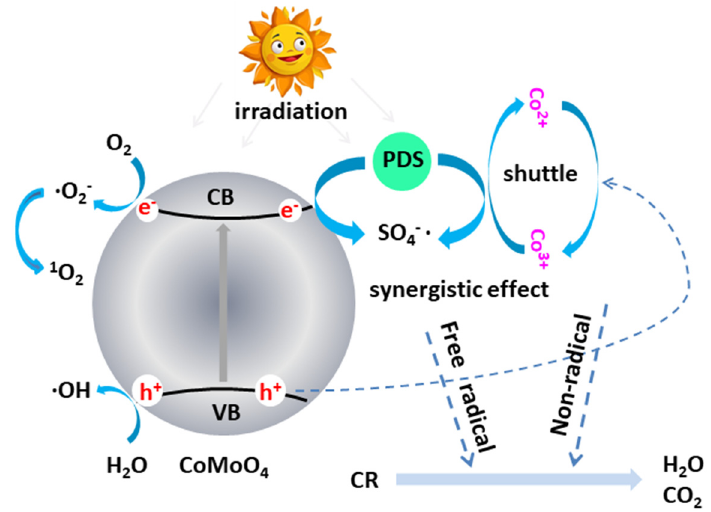
Figure 11. Photo-Fenton mechanism of CoMoO 4 /PDS system.